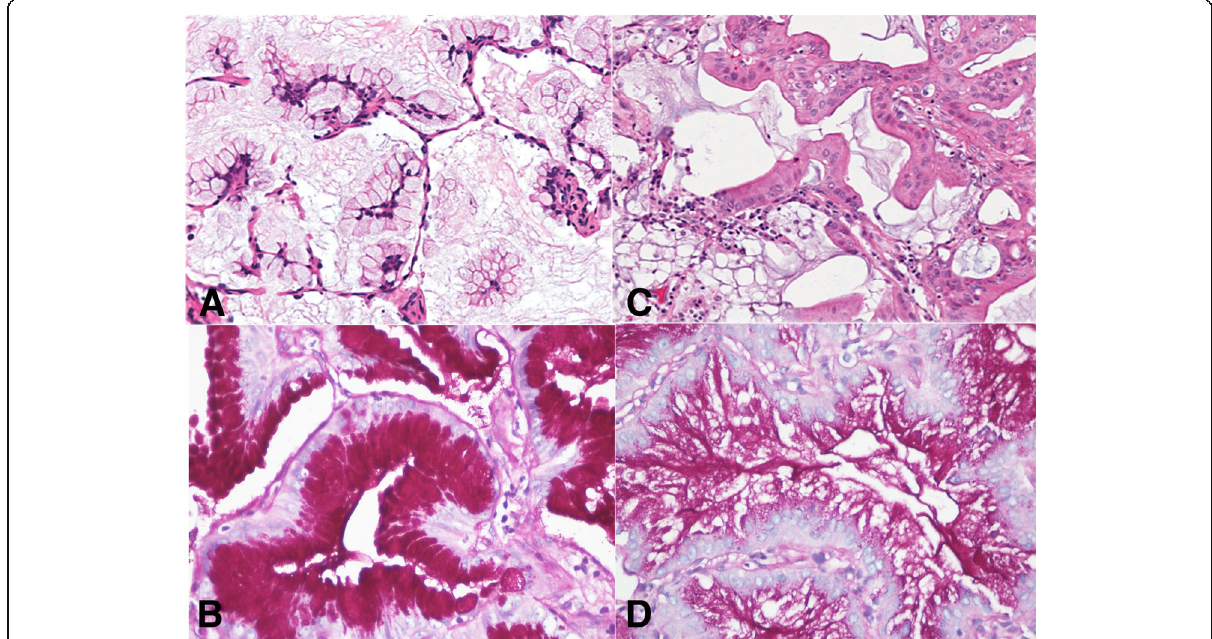
Fig. 1 Types of tumor cell. a . Columnar cells with cytoplasmic clearing. b . PAS (with diastase pretreatment) demonstrates diffuse cytoplasmic staining with basal nuclei. c . Cuboidal cells with eosinophilic cytoplasm. d . PAS/diastase shows apical and brush border mucin with extravasation into glandular lumen